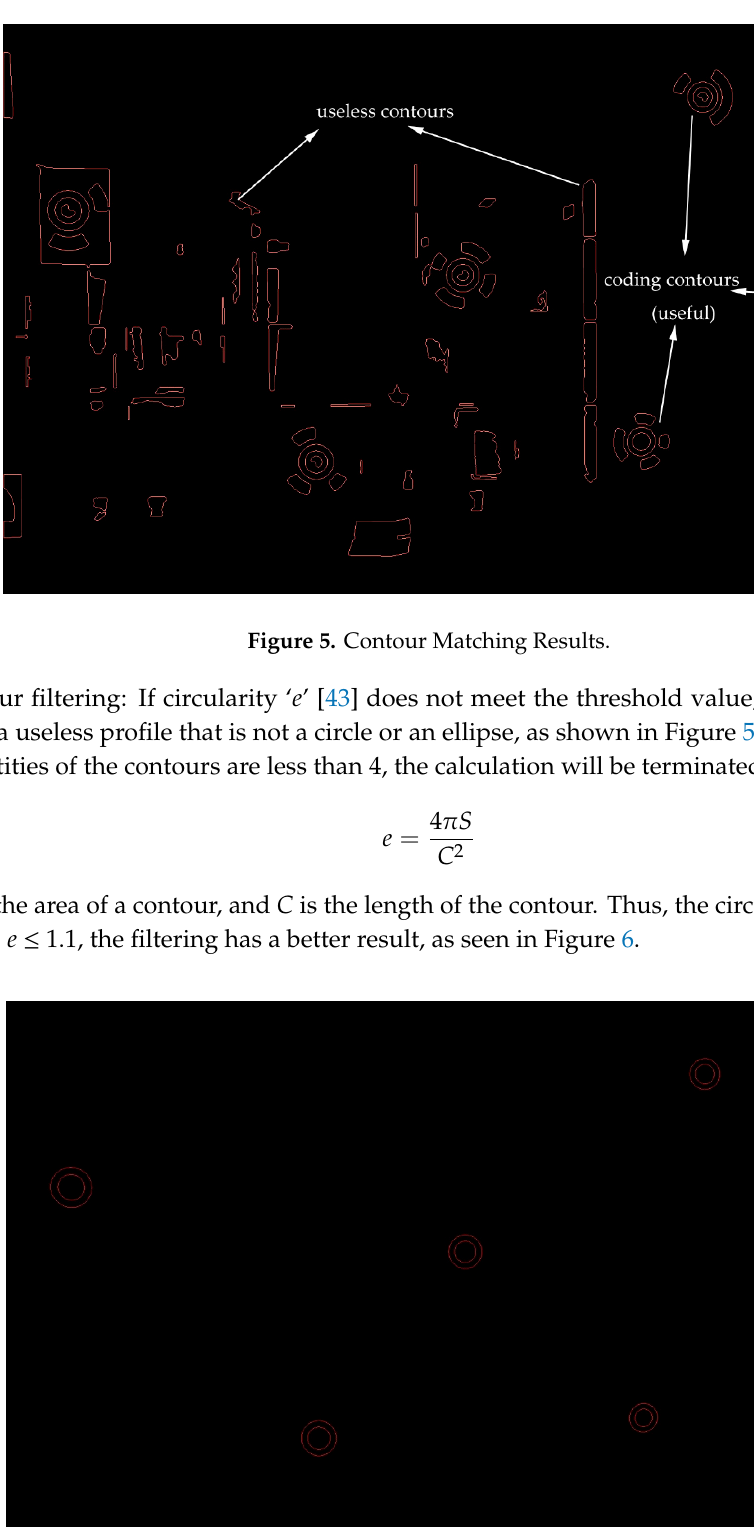
Figure 6. Interference Contour Culling Results.